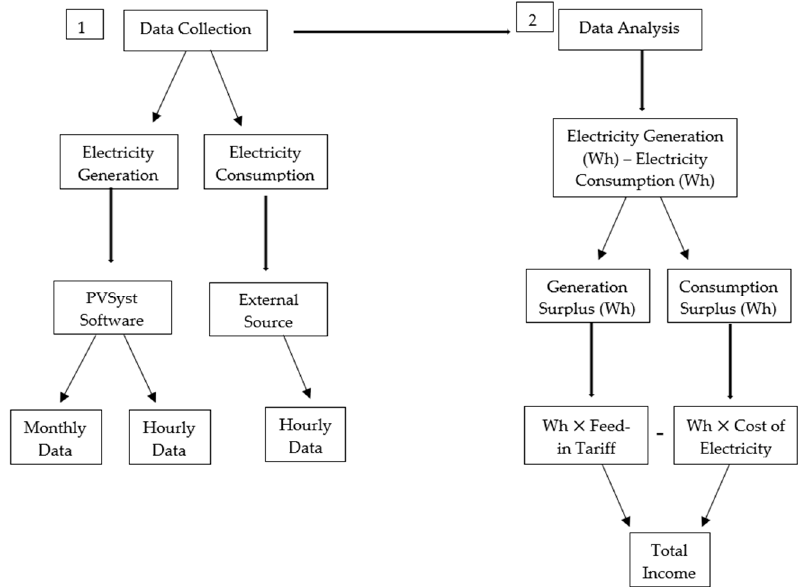
Figure 1. Flowchart of research framework design for data collection and analysis.